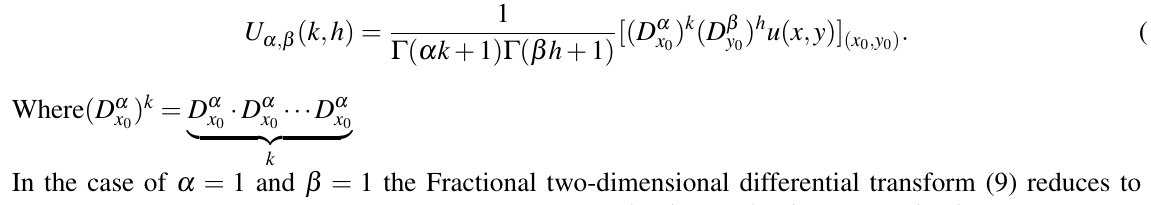
Table 1. The operations for the two-dimensional differential transform method